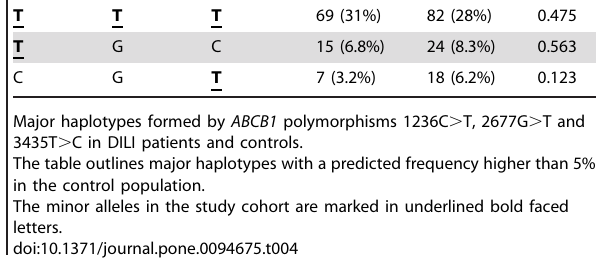
1236T . C 2677G . T 3435T .